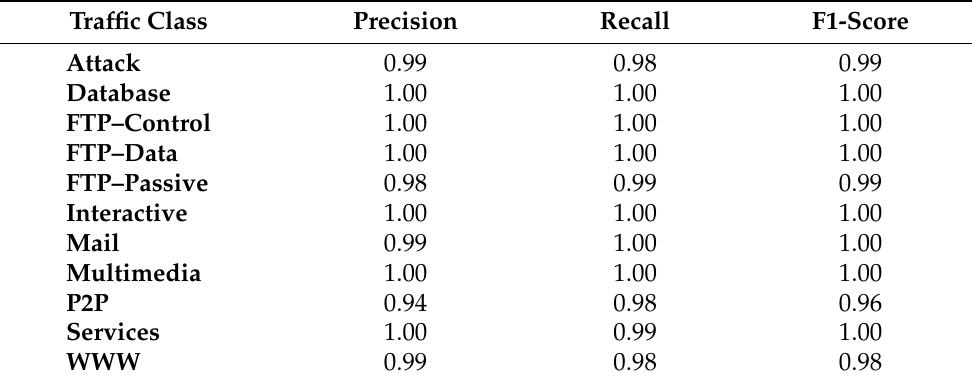
Table 6. Precision, recall, and F1-score per class for DT classification.